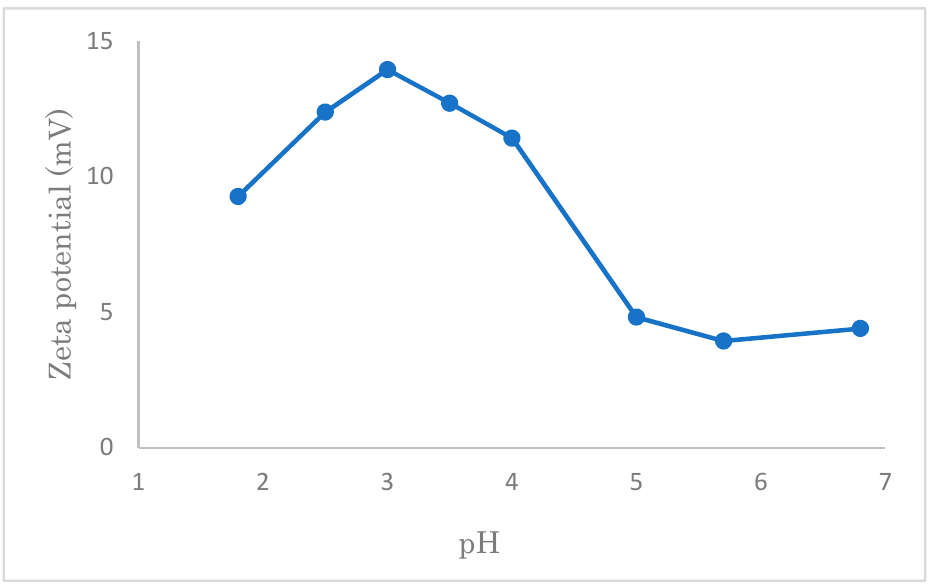
Table 5. Comparison of the adsorption capacity of different adsorbents.